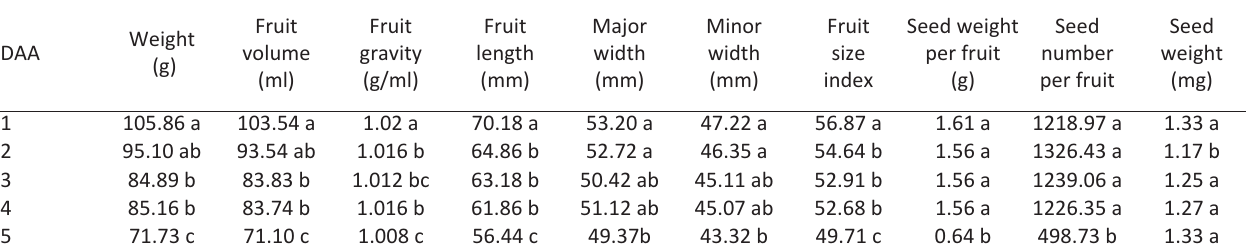
Table 2 ­ Effects of hand pollinating Actinidia deliciosa ‘Hayward’ flowers 1, 2, 3, 4, or 5 days after anthesis (DAA) on fruit characteri­ stics. Fruit were harvested 7 Nov.